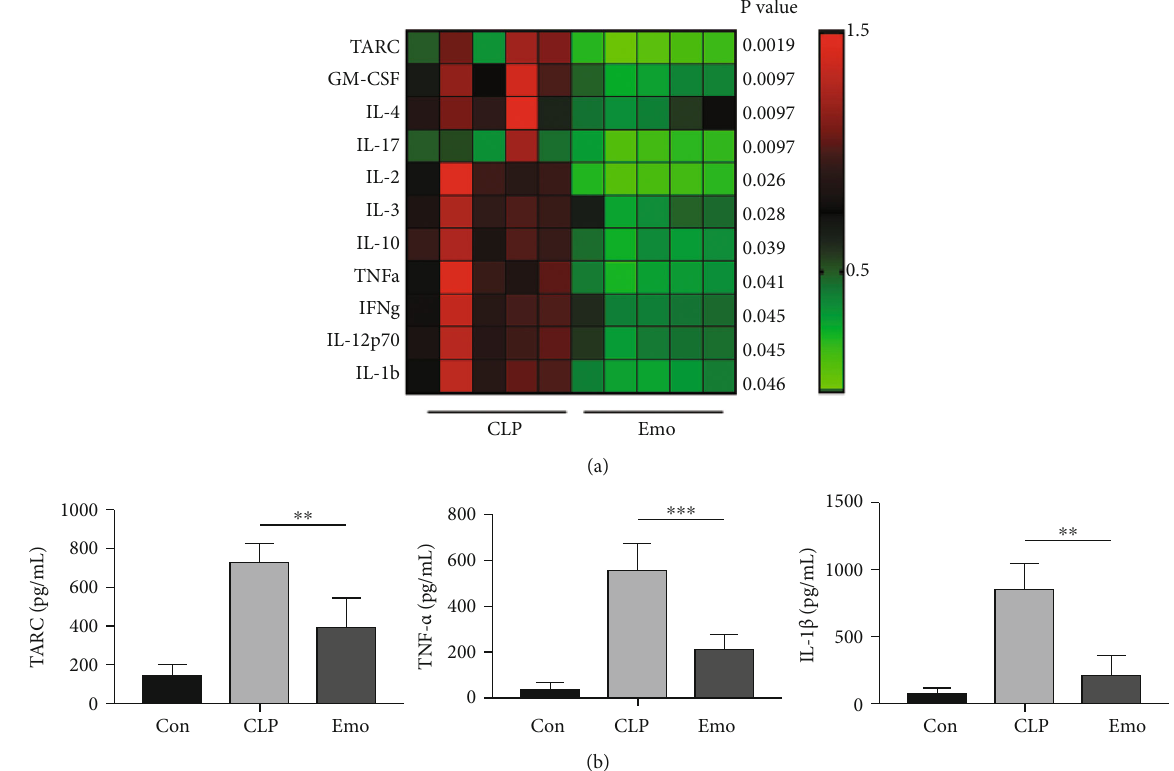
Figure 2: Emodin inhibits in fl ammatory response in intestine of septic mice. (a) Cytokines microarray was employed for detection of in fl ammatory factors. Fold changes of CLP group were indicated in the heat map, and di ff erences between mean values were assessed. p < 0 : 05 indicates signi fi cant di ff erence compared with CLP group. (b) Identi fi cation of results from cytokines microarray by ELISA. Data represent the mean ± SD of three independent experiments, and di ff erences between mean values were assessed by one-way ANOVA. ∗∗ p < 0 : 01 , ∗∗∗ p < 0 : 001 indicate signi fi cant di ff erences compared with CLP